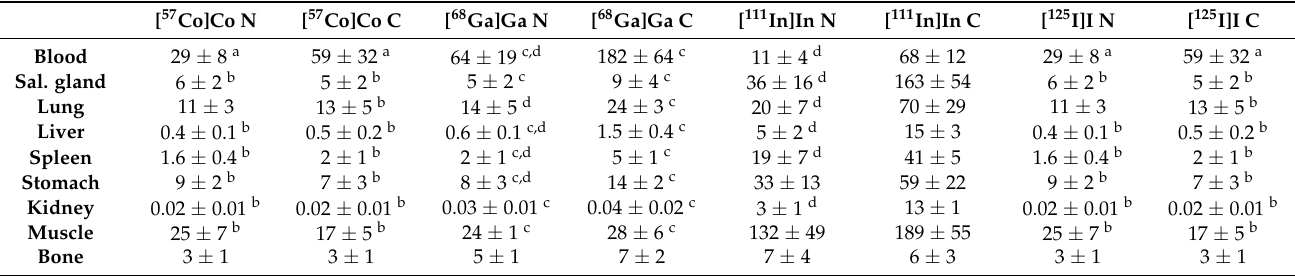
Figure 5. Tumor-targeting specificity of DARPin Ec1 variants labeled with [ 57 Co]Co, [ 68 Ga]Ga, [ 111 In]In and [ 125 I]I-HPEM at N- or C-terminus 3 h post injection (p.i.) in Balb/c nu/nu mice bearing EpCAM-expressing DU145 xenografts (n = 4–7) and EpCAM-negative Ramos xenografts (control, n = 4). Uptake is presented as % ID/g ± SD.